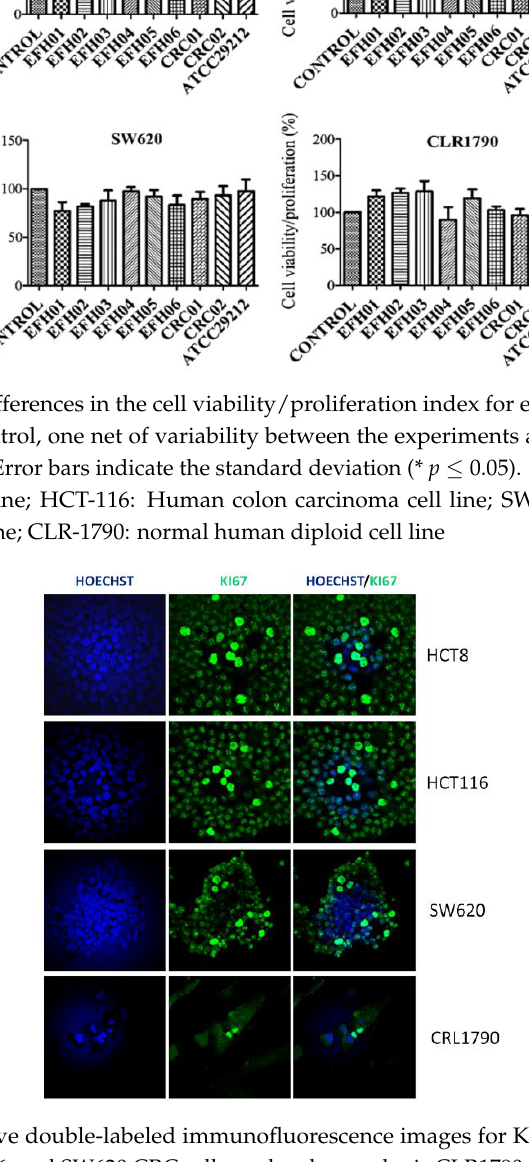
Figure 4. Ki67 positive HCT8, HCT116, SW620, and CLR1790 cells after 72 h of exposure to the metabolites produced from different strains of E. faecalis . Error bars indicate the standard deviation (* p ≤ 0.05). 4. Discussion In this study, aiming to investigate the potential role of E. faecalis in CRC development, we compared the effect of E. faecalis strains isolated from CRC patients’ and healthy subjects’ stools on the viability/proliferation of different colorectal cells lines. Actually, gut microbes can regulate the colonic epithelial cells’ homeostasis (proliferation, differentiation, and apoptosis) and GM dysbiosis has been widely associated with CRC development [12–14]. In addition, metagenome-wide association studies on fecal samples have characterized numerous microbial markers of CRC [40,41]. Some authors documented a higher abundance of E. faecalis in CRC tumor and adjacent tissue [42], as well as in stool samples of CRCpatients [23,43], as compared to healthy subjects. However, in our cohort of patients, we did not confirm these previous findings. In detail, only two out of the nine CRC patients had cultivable E. faecalis in stool samples, while in healthy donors, we detected strains in